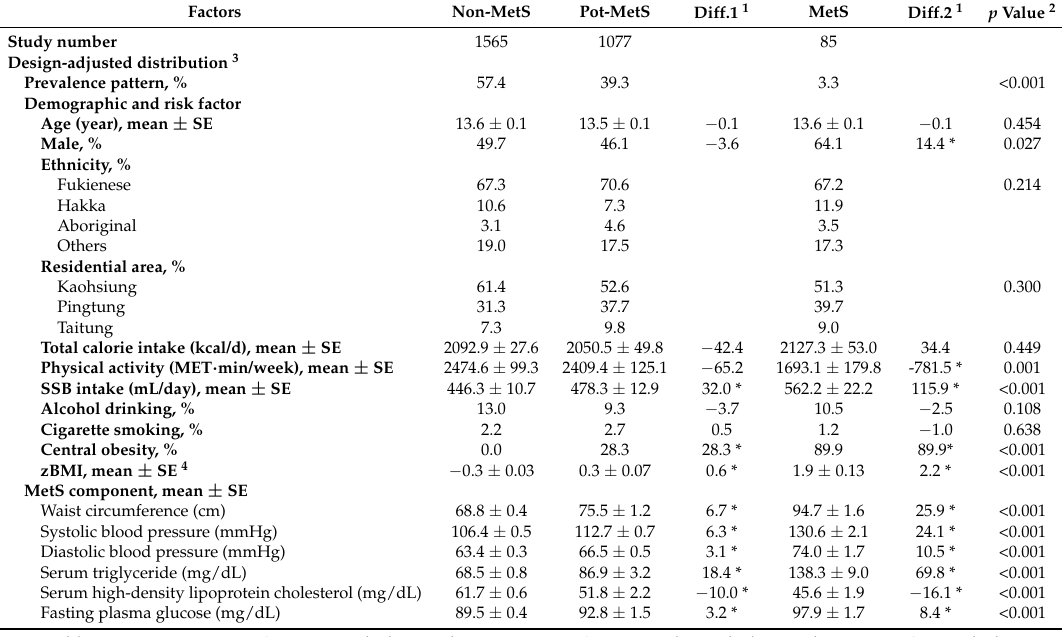
Table 1. Demographic backgrounds and risk factors of adolescents in relation to metabolic syndrome